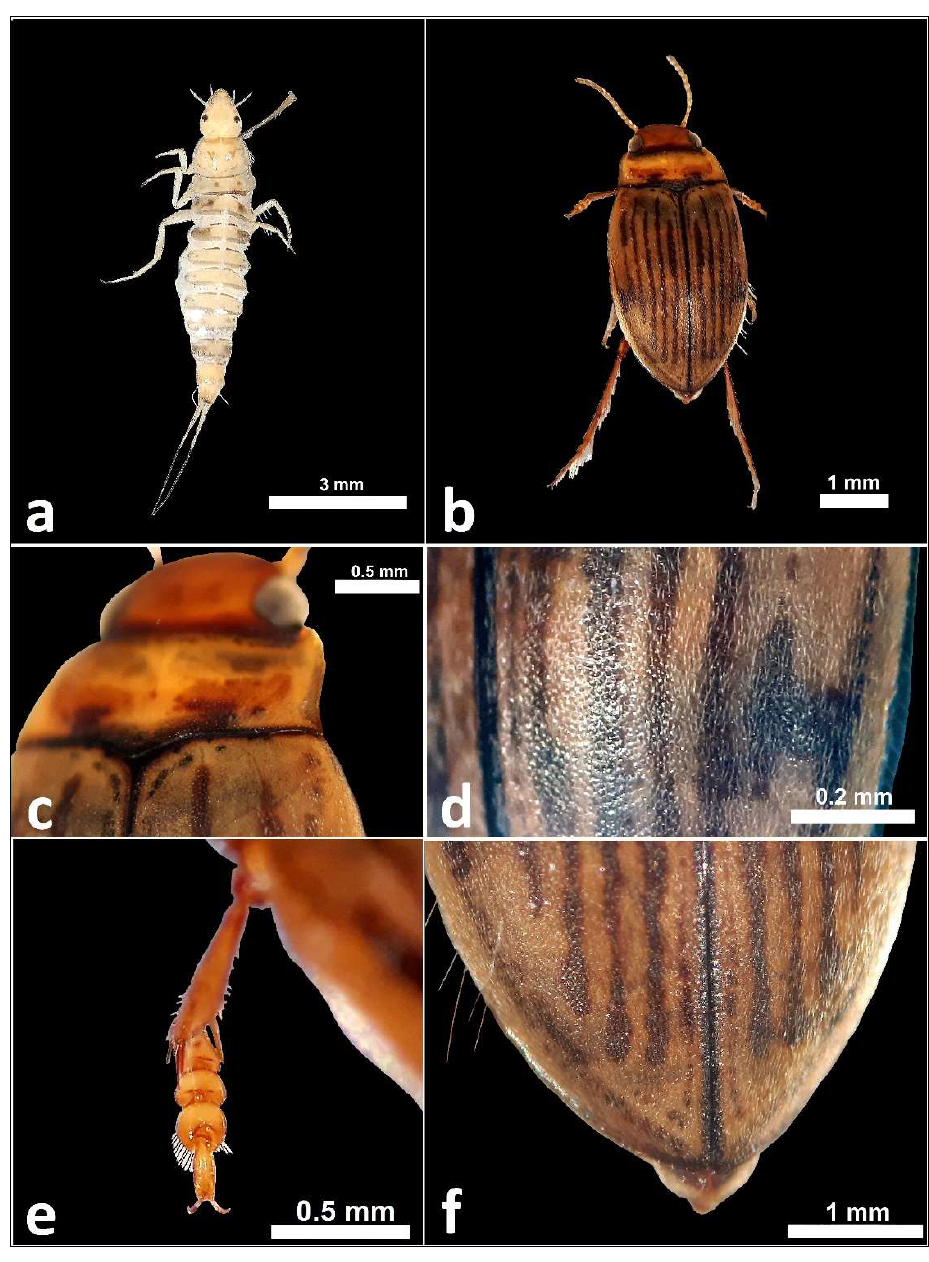
Figure 5. Nebrioporus ceresyi : ( a ) late larva; ( b ) imago, dorsal view; ( c ) detail of the posterior angles of the pronotum; ( d ) detail of the punctuation of the elytra; ( e ) tarsomeres of left limb, dorsal view; ( f ) apex of the elytra.